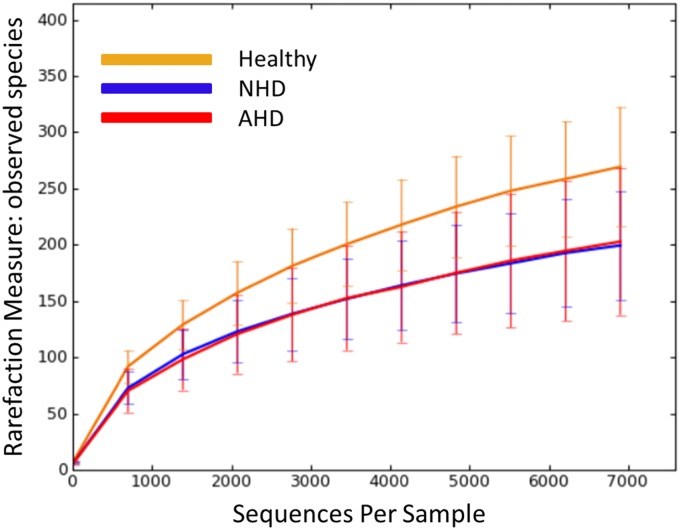
Rarefaction analysis of 16S rRNA gene sequences obtained from canine fecal samples.Lines represent the mean and error bars represent standard deviations. The analysis was performed on a randomly selected subset of 6,900 sequences per sample. NHD = acute non-hemorrhagic diarrhea; AHD = acute hemorrhagic diarrhea.